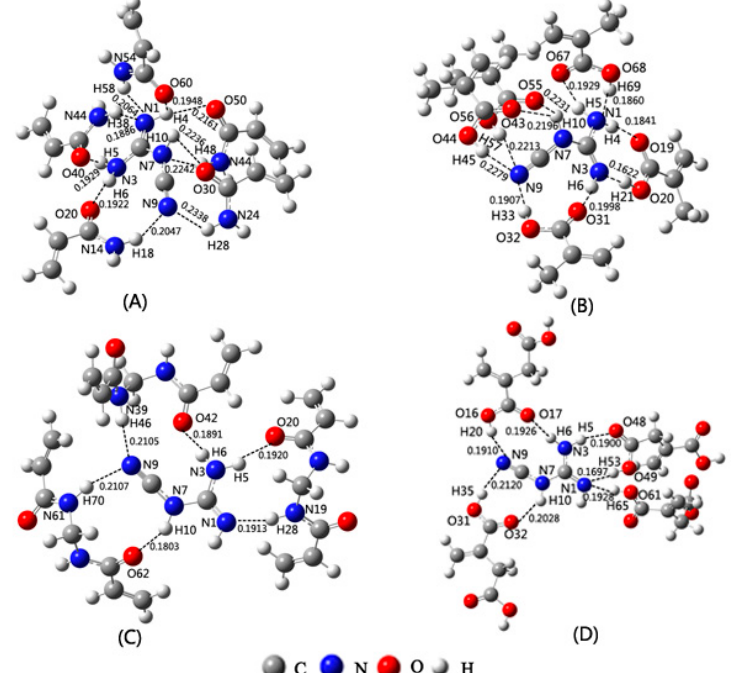
Figure 3. Models of complexes formed from DCD and the functional monomers of AM ( A ); MAA ( B ); MBA ( C ); and IA ( D ).